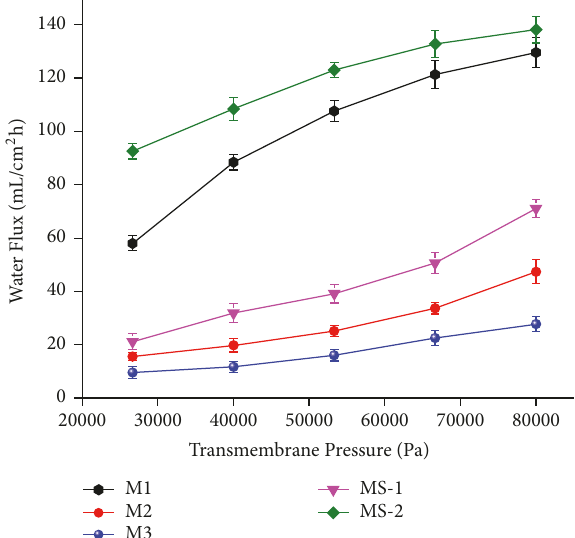
Figure 5: Water flux of membranes prepared by polymer concen- tration variation and solvent